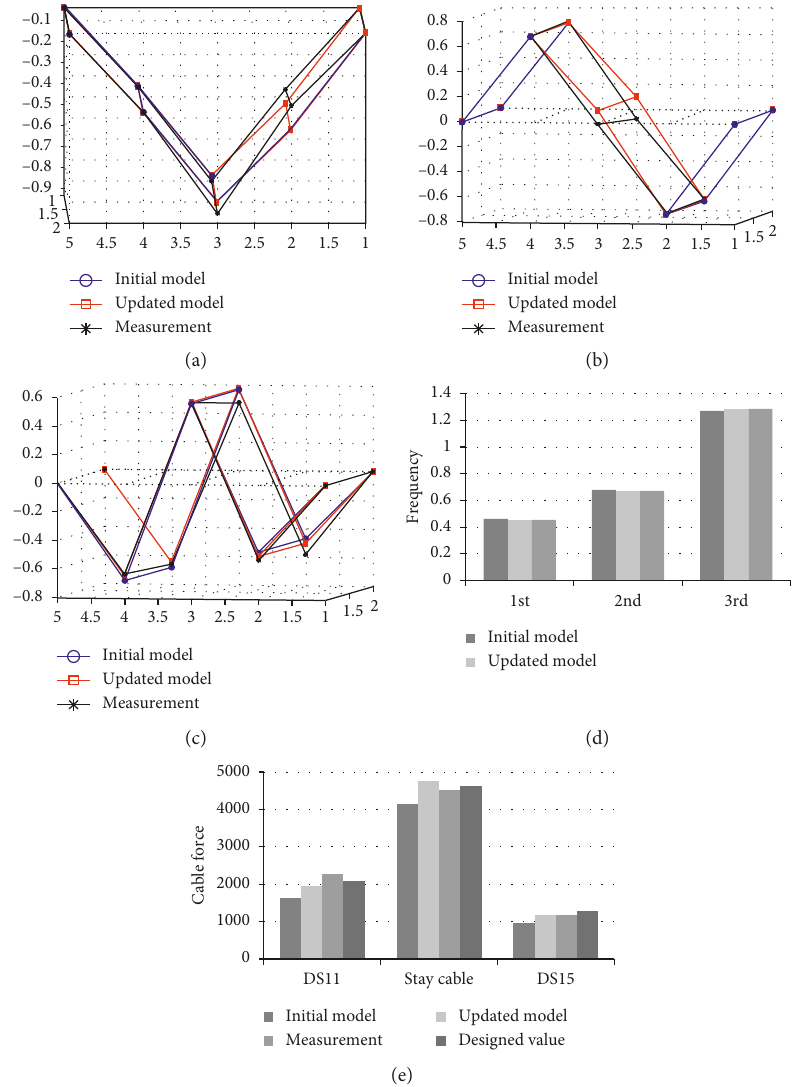
Figure 10: Comparison of dynamic test results. (a) First model. (b) Second model. (c) Third model. (d) Frequency. (e) Cable force. 34°